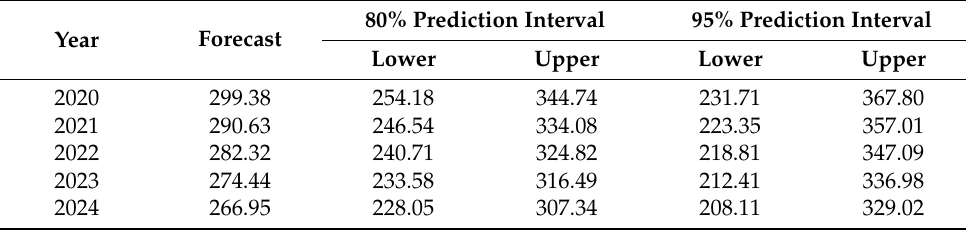
Table 6. Forecast and prediction interval over a period of 5